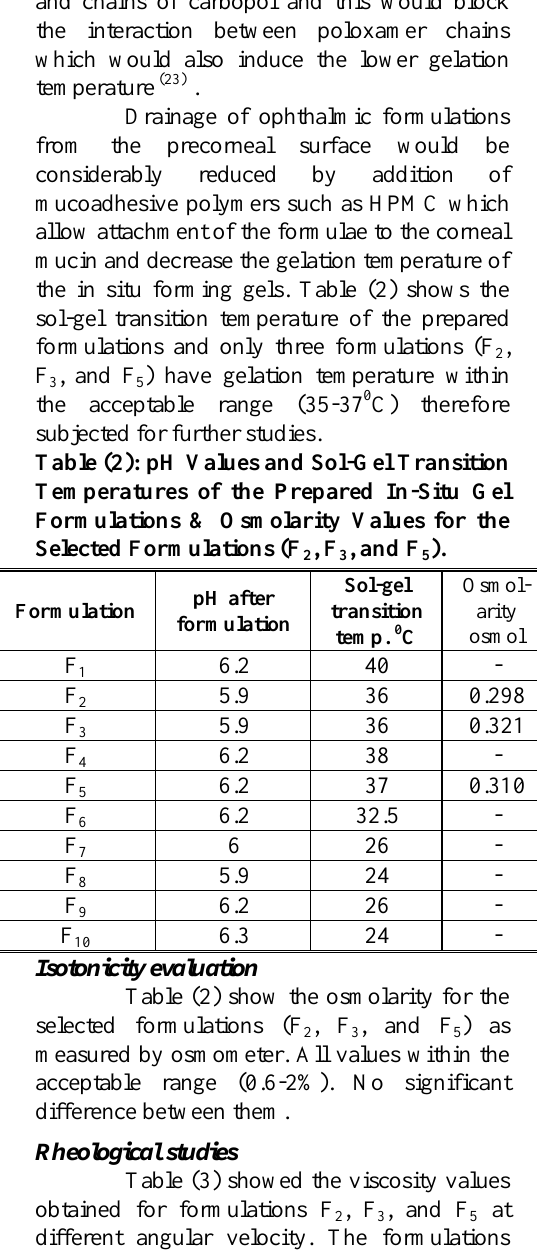
Table (2): pH Values and Sol-Gel Transition Temperatures of the Prepared In-Situ Gel Formulations & Osmolarity Values for the Selected Formulations (F